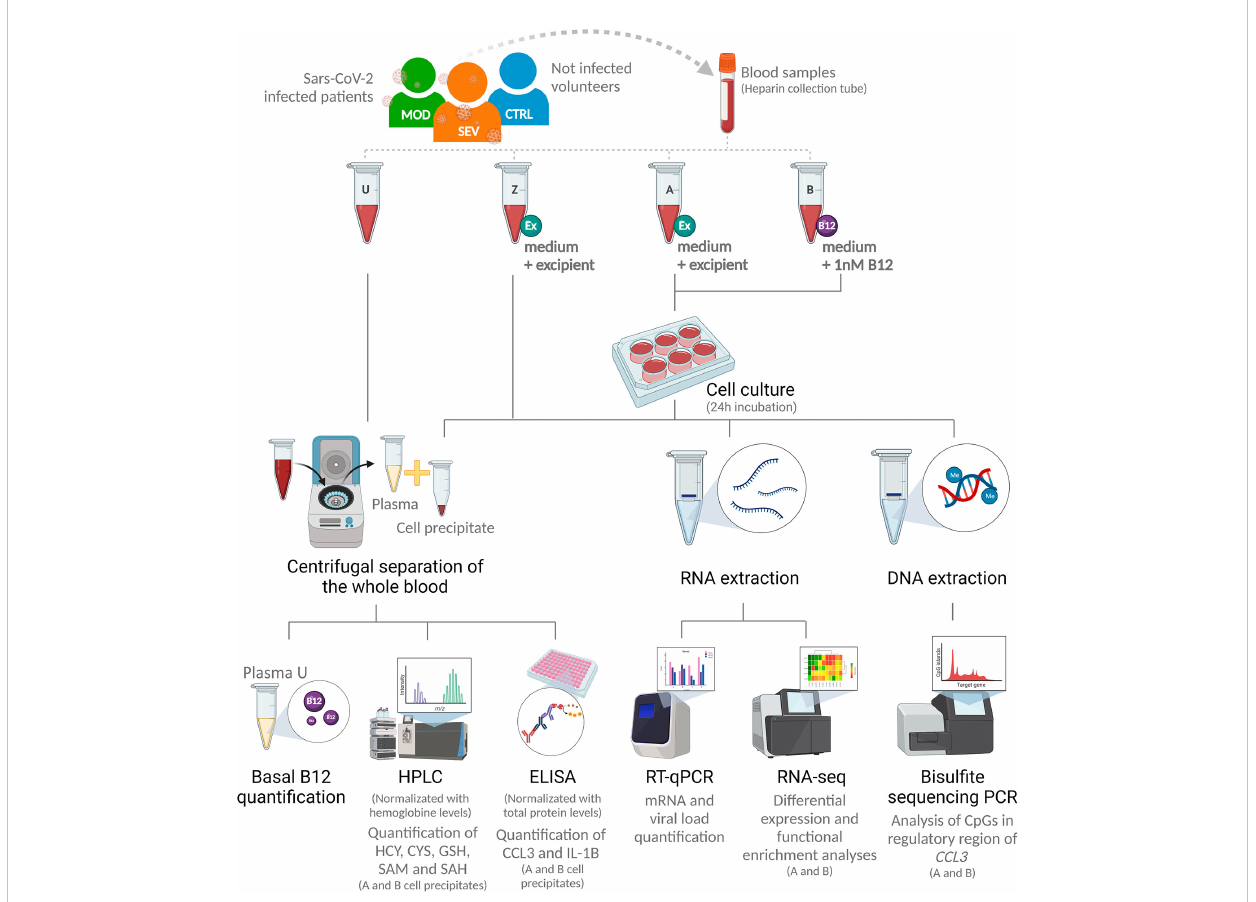
FIGURE 2 Research design. SEV, severe COVID-19; MOD, moderate COVID-19; CTRL, non-infected controls; U, endpoint U (unprocessed blood); Z, endpoint Z (samples immediately processed after addition of culture medium with excipient); A, endpoint A (Samples added to culture medium with excipient and incubated for 24h); B, endpoint B (Samples added to culture medium with B12 and incubated for 24h); Ex, Excipient; B12, Vitamin B12; HPLC, High Performance Liquid Chromatography; HCY, Homocysteine; CYS, Cysteine; GSH, Glutathione; SAM, S-adenosylmethionine; SAH, S-adenosyl-L- homocysteine; PCR, Polymerase Chain Reaction; RT-qPCR, Real-time quantitative PCR. (Created with